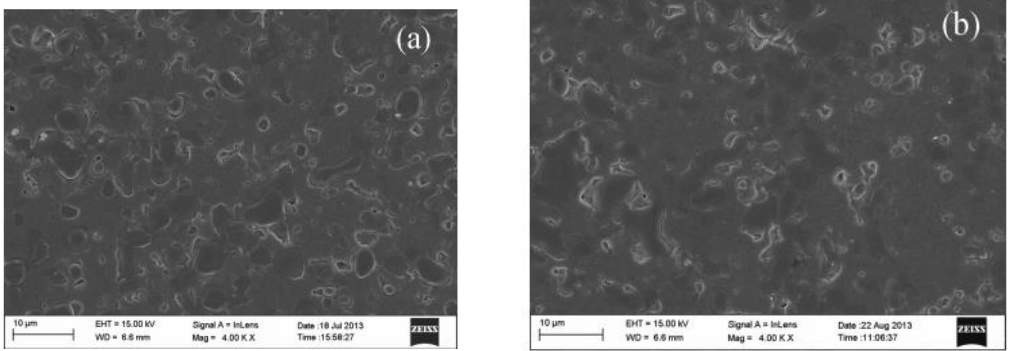
Figure 6. SEM images of Ni-BZCYYb sintered at 900 °C for 200 h in 20% CO 2 containing atmosphere, ( a ) the original membrane, and ( b ) the sintered membrane [44].